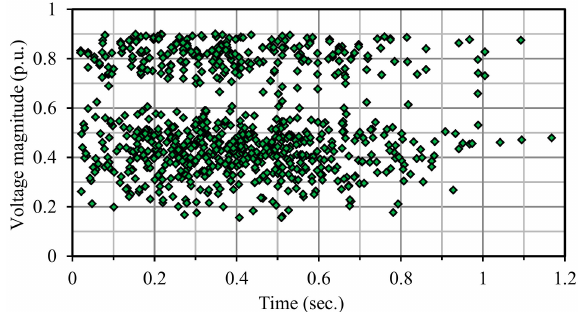
Figure 7. SD associated with load point 1.